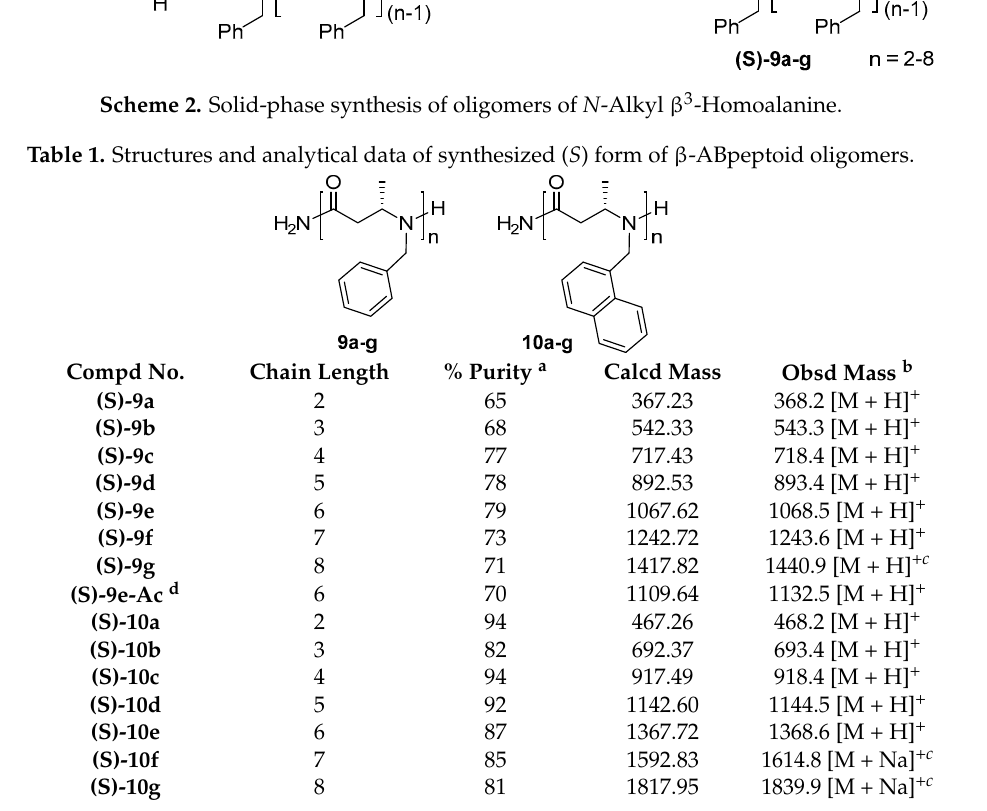
Table 1. Structures and analytical data of synthesized ( S ) form of β -ABpeptoid